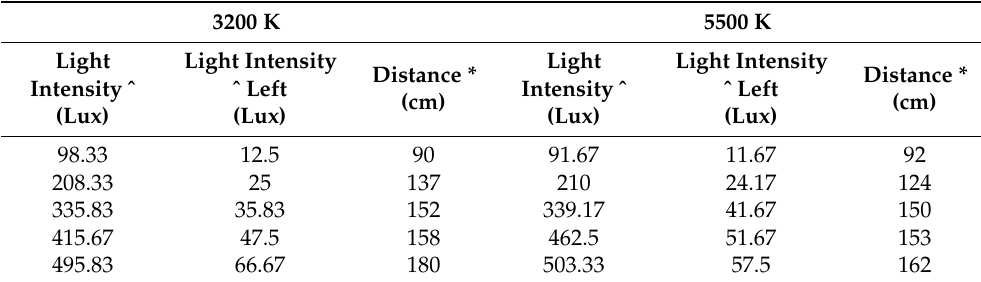
Table 6. Compare the relation among light intensity (Lux), light color (Kelvin), and detection distance (cm) for light source without diffuser from left side.